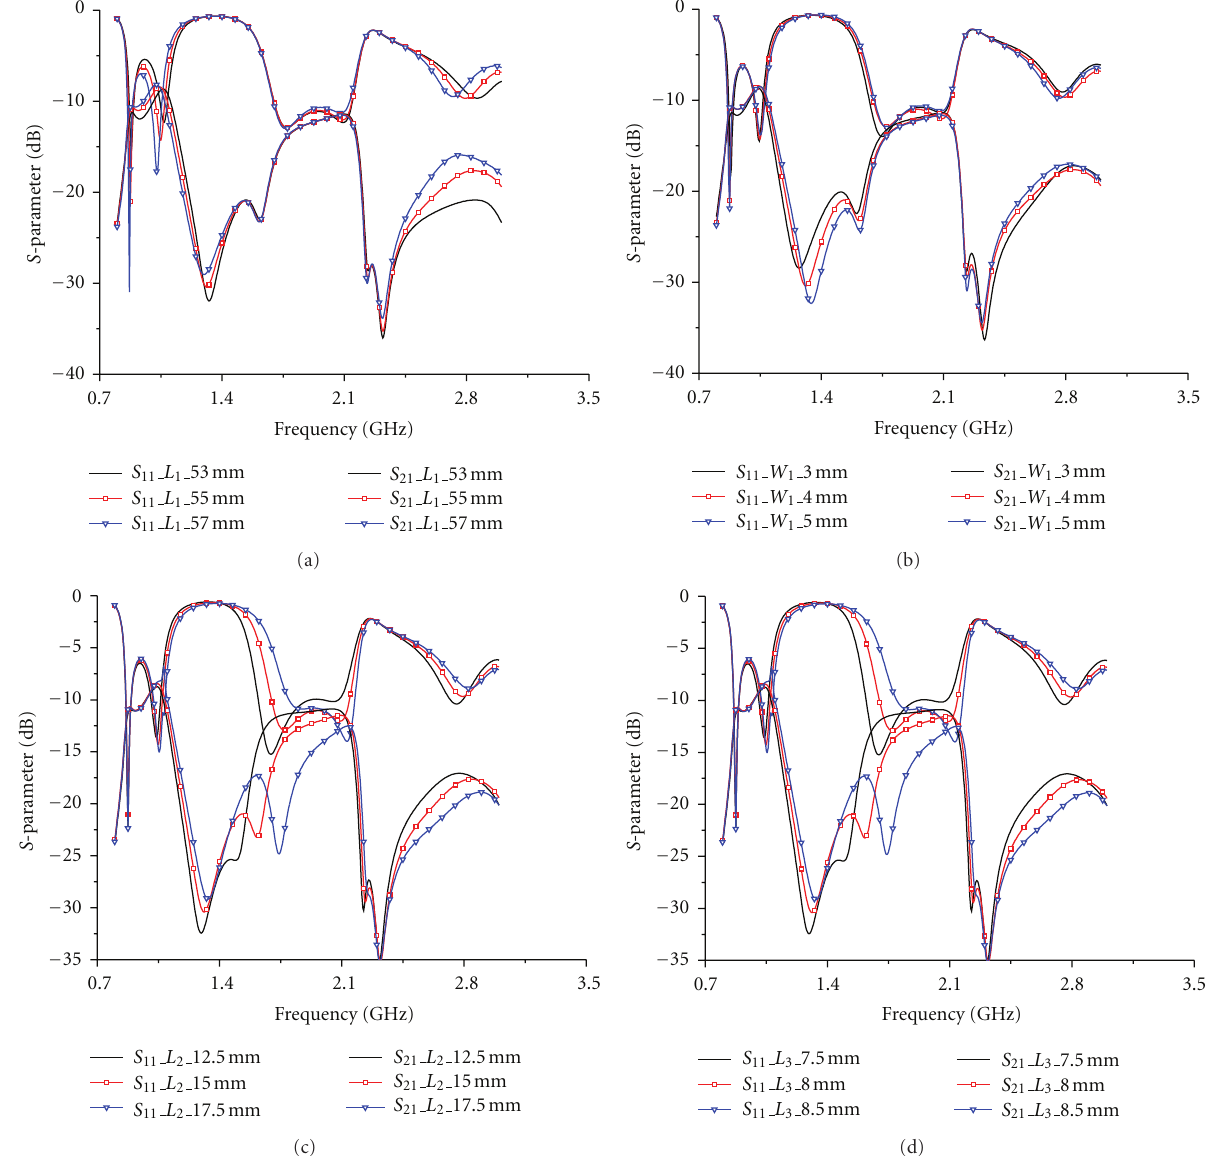
Figure 3: Parameter studies of L 1/ W 1/ L 2 and L 3; the nominal values of the dimensions are L 1 = 55mm/ W 1 = 4mm/ L 2 = 15mm/ L 3 =